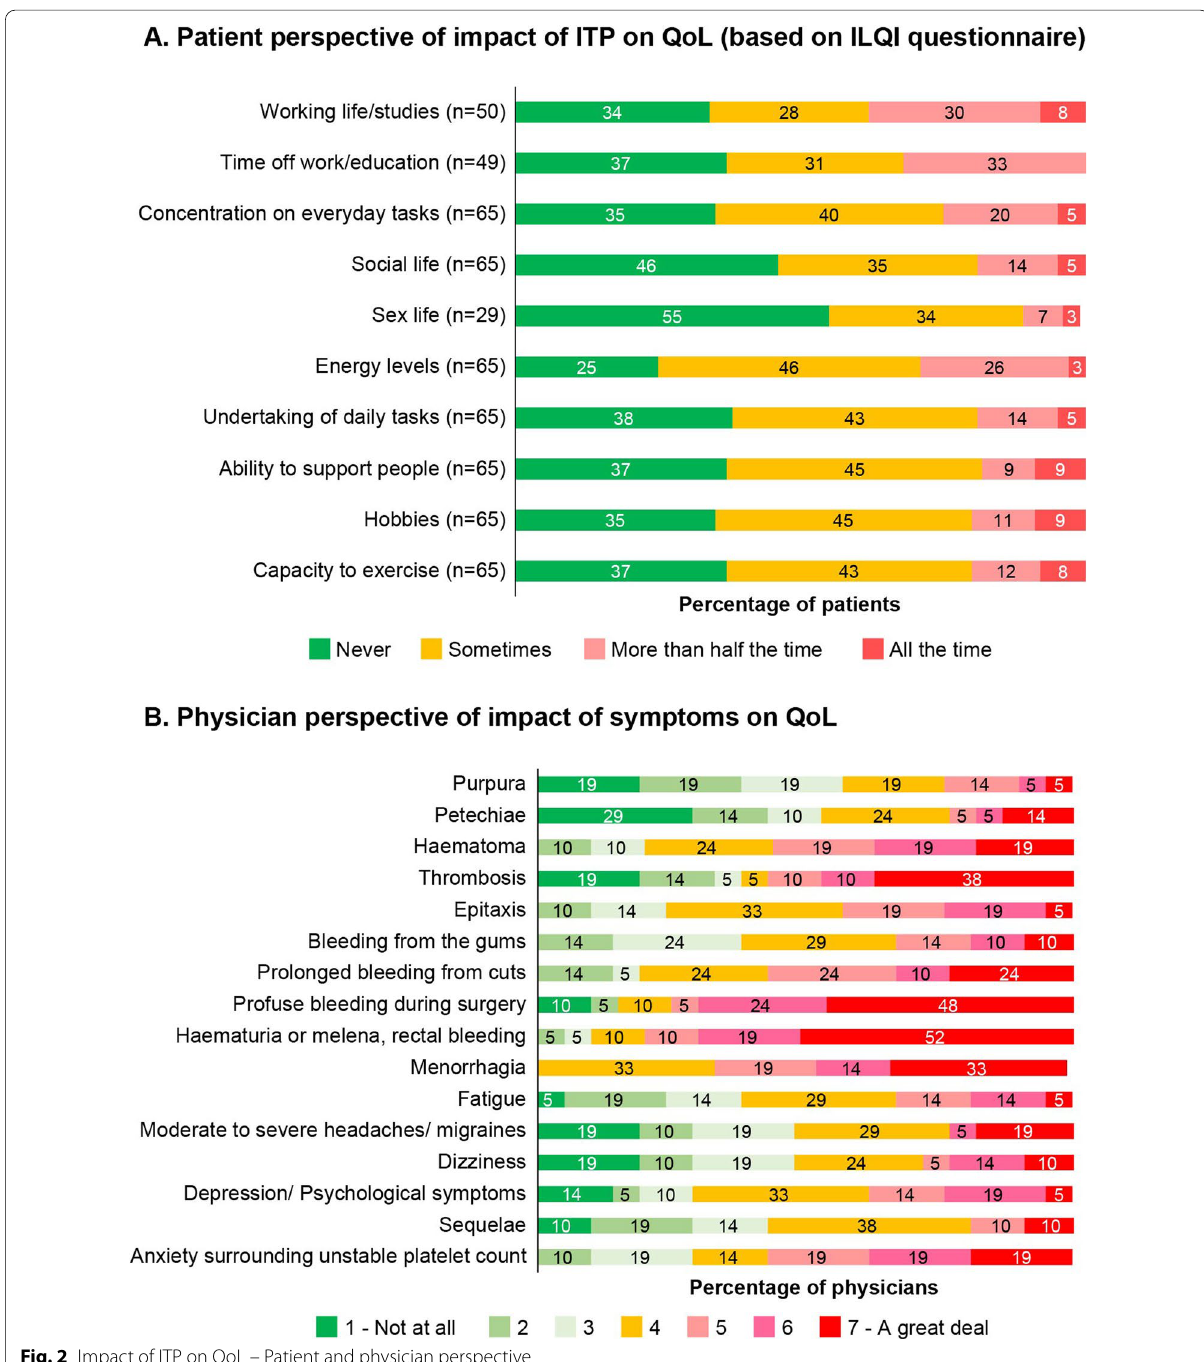
Fig. 2 Impact of ITP on QoL – Patient and physician